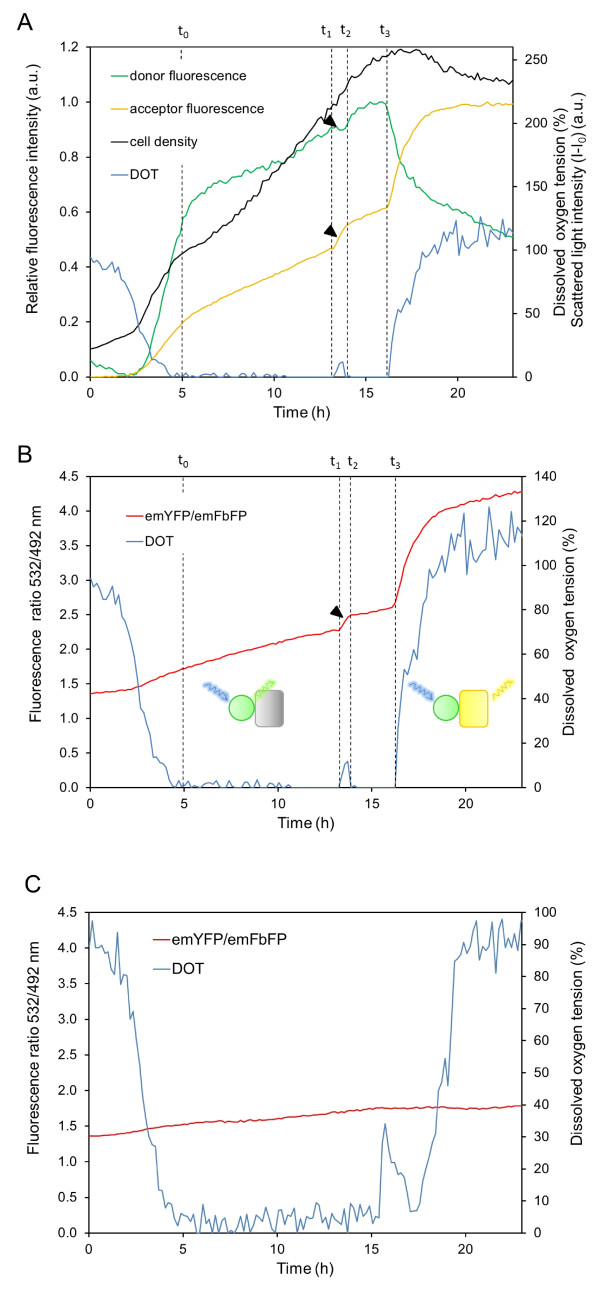
Determination of intracellular oxygen concentration in E. coli. E. coli cells expressing FluBO were batch cultured in Overnight Express™ Instant TB medium in 48-well flowerplates using the microcultivation system BioLector. The development of biomass (black), dissolved oxygen tension (blue) and FP-mediated fluorescence (FbFP: green, YFP: yellow) was online-monitored in each well of the flowerplate. Cell density was monitored by scattered light (I-Io) at an excitation wavelength of 620 nm (a.u.: arbitrary units). Time points of changing DOT of the growth medium are labeled (t0 to t3). Arrowheads indicate changes of donor and acceptor fluorescence which is caused by a temporary shift of DOT during the logarithmic growth phase. (A) Fluorescence emission of donor (FbFP) and acceptor (YFP) was recorded at 492 nm and 532 nm, respectively, with an excitation wavelength of 380 nm. (B) Development of cyan-to-yellow fluorescent ratio (emYFP/emFbFP) of the FRET-based oxygen biosensor is shown in red. The pictograms symbolize the state of fluorescence activity of the FbFP donor domain (circle) and YFP acceptor domain (rectangle). (C) Background fluorescence of E. coli during cell growth. E. coli cells carrying the empty expression vector were batch cultured in Overnight Express™ Instant TB medium in 48-well flowerplates using the BioLector. Dissolved oxygen tension is shown in blue. According to emFbFP and emYFP, cell-dependent background fluorescence was online recorded at 492 nm and 532 nm that, respectively, at an excitation wavelength of 380 nm and the fluorescence ratio was calculated (red curve). All parallel fermentation experiments in the microwells were performed in triplicates. These results were in excellent agreement (see Additional File 4). Maximum time shifts of 10 minutes occurred due to unavoidable slight differences of cell density at the beginning of the cultivation. Therefore, a representative set of data from these three parallel independent measurements instead of the corresponding mean values is shown in the figures.